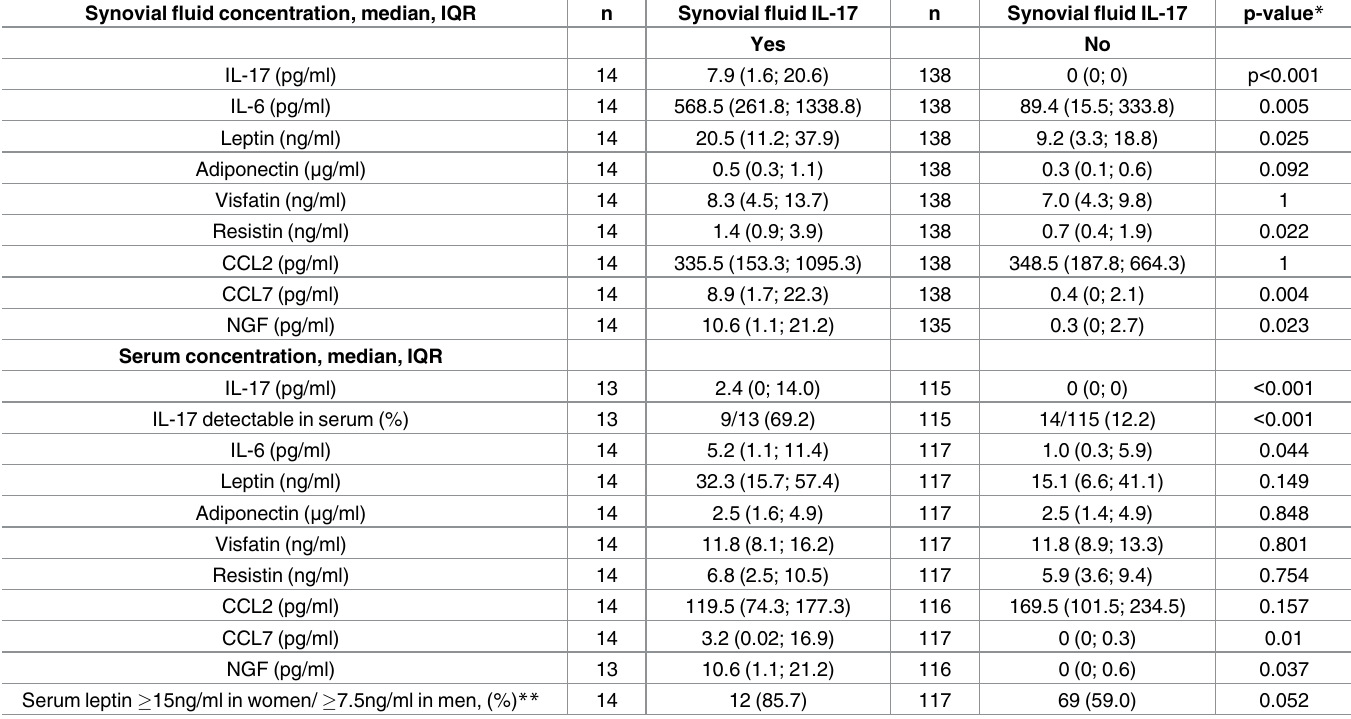
Table 1. Synovial fluid IL-17 levels in relation to synovial fluid and serum adipokines and cytokines. Synovial fluid concentration, median, IQR n Synovial fluid